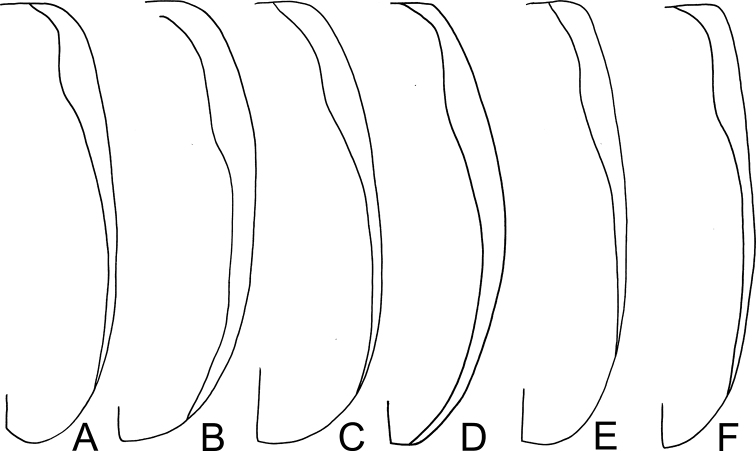
Elytron, ventral view AAtrachya
menetriesiiBChinochya
unifasciataCMonolepta
gracilipesDNeochya
nitidissimaEPaleosepharia
formosanaFTsouchya
mediofasciata.